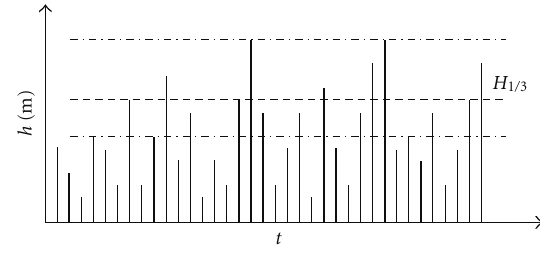
Figure 1: Waves height over time.